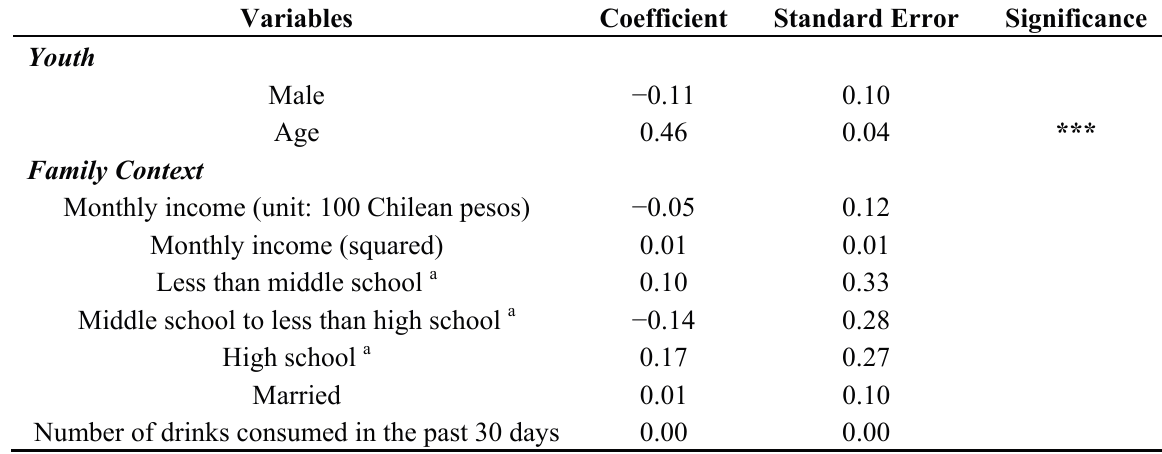
Table 3. Propensity Score Estimation with Probit Regression Model ( N =